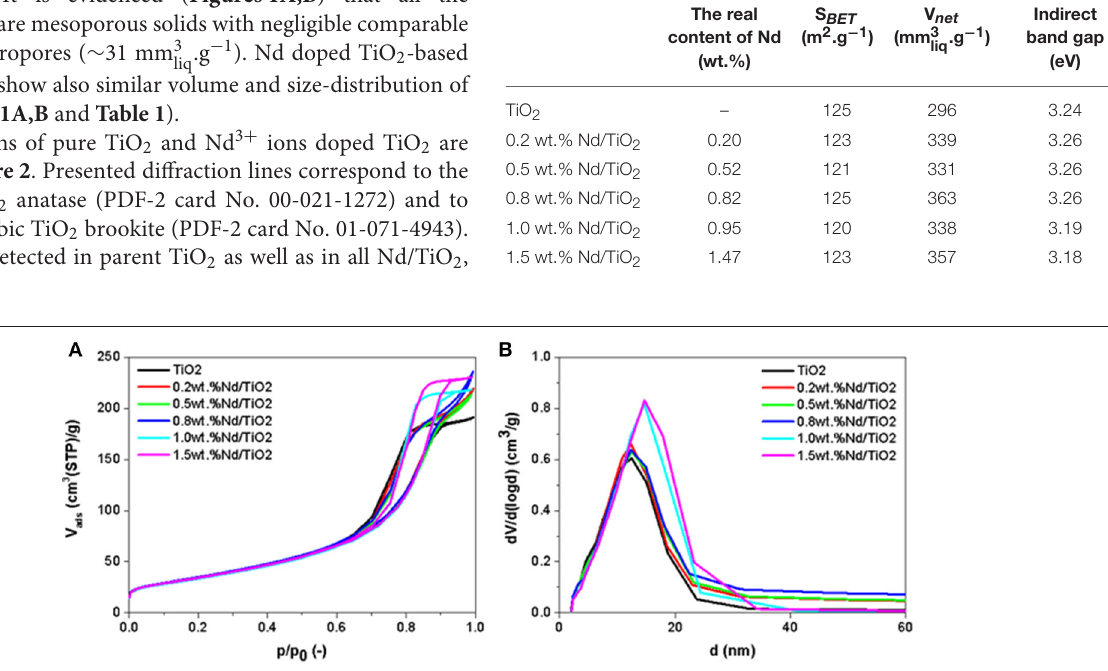
Frontiers in Chemistry |